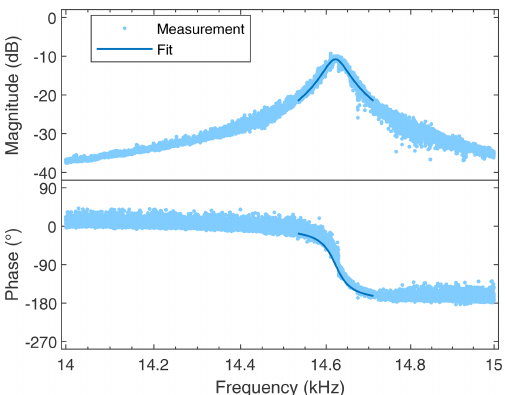
Figure 10. Bode plot of the first out-of-plane bending-mode contact resonance peak, measured on a thin film of PnBMA polymer (light blue dots) and a fit of the model (dark blue